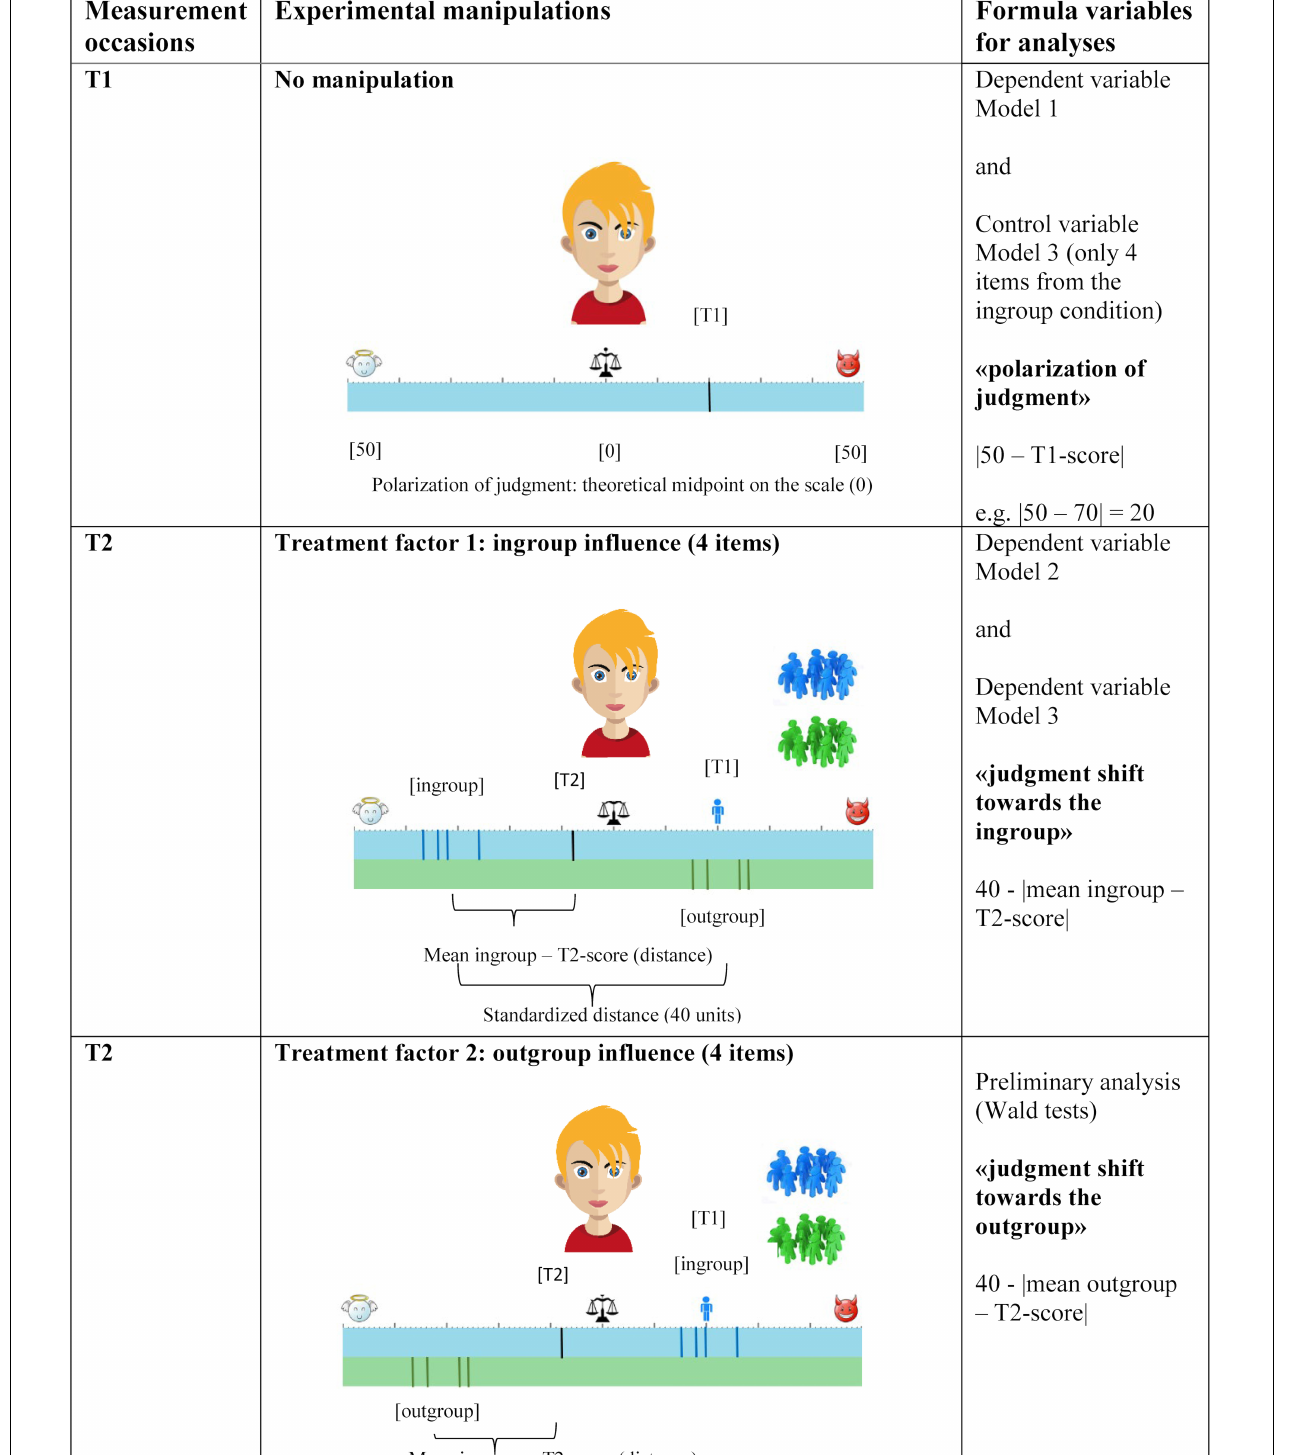
Frontiers in Psychology |